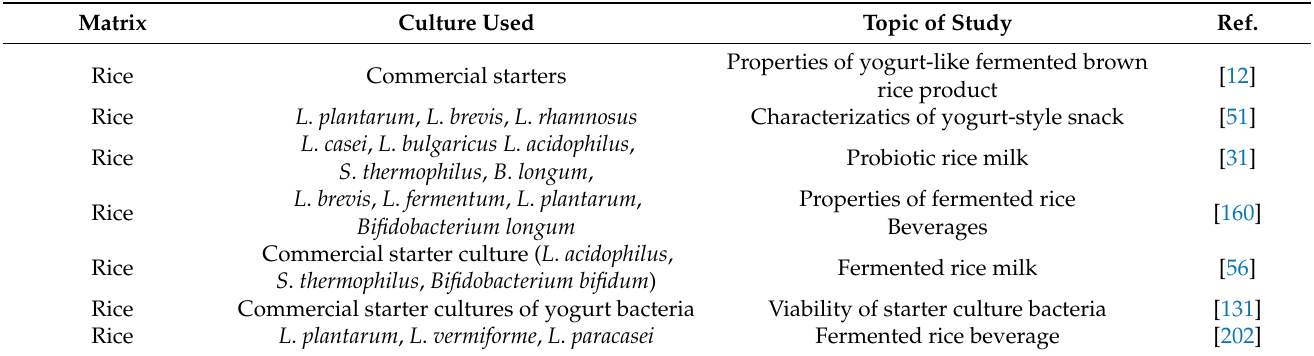
Table 8. Studies employing LAB as starter cultures in fermentation of cereal- and pseudocereal-based beverages (examples). Matrix Culture Used Topic of Study